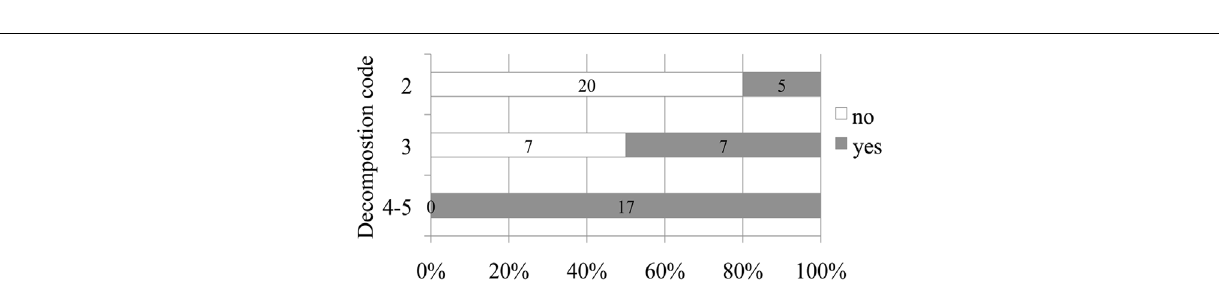
FIGURE 2 | Number and relative percentage of non-deep diving animals in which bubbles were observed (in dark gray) compare to those in which bubbles were absent (in white) attending to decomposition code.